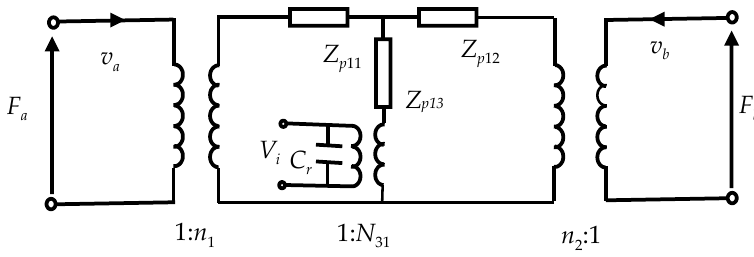
Figure 2. Electromechanical equivalent circuit of the piezoelectric ceramic tube on the radial vibration.